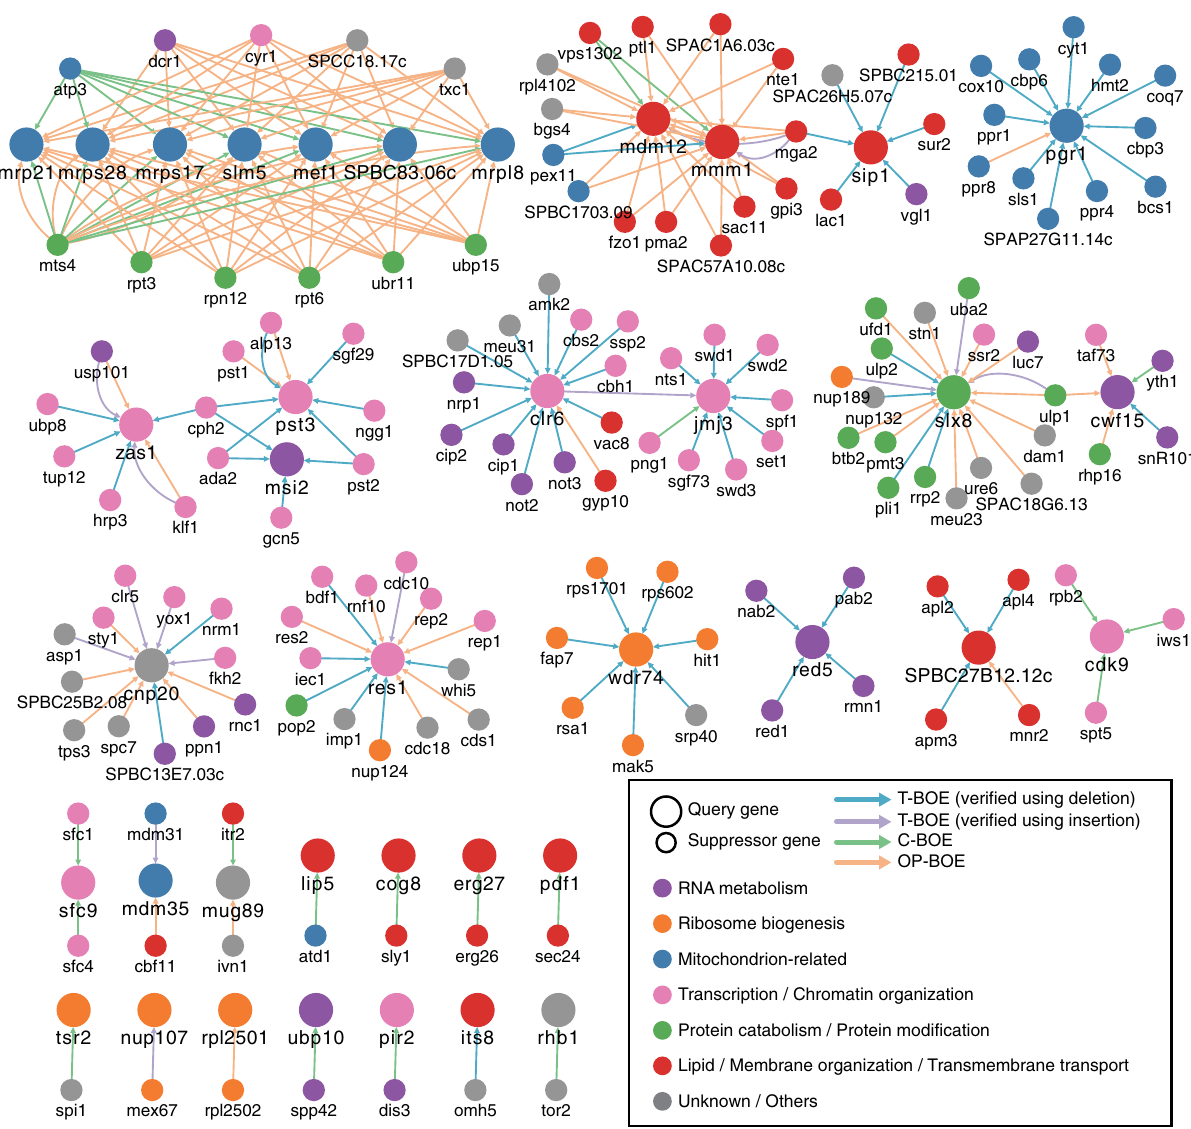
Fig. 2 BOE interactions that bypass the 38 chrII-L essential genes. Genes are represented as nodes, and BOE interactions are represented as directed edges pointing from suppressor genes (small nodes) to query essential genes (large nodes). Node colors represent the indicated gene functional categories and edge colors represent the indicated